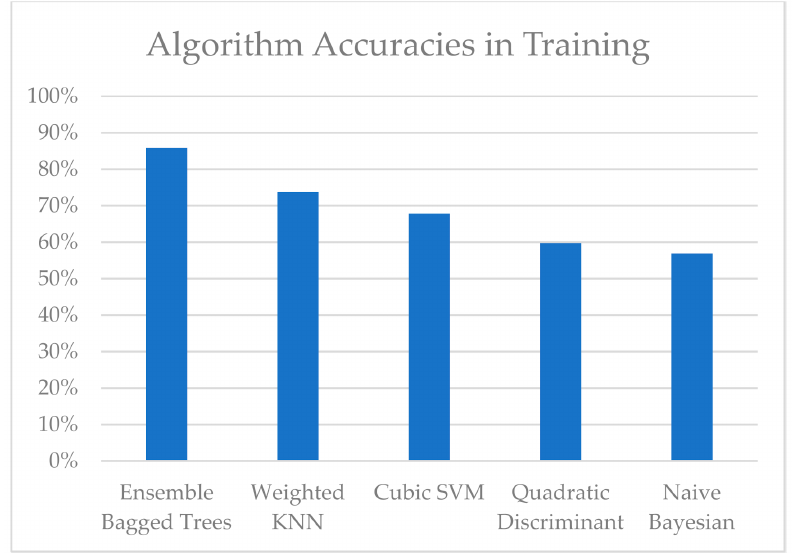
Figure 9. Accuracy results for different algorithms for the CWRU